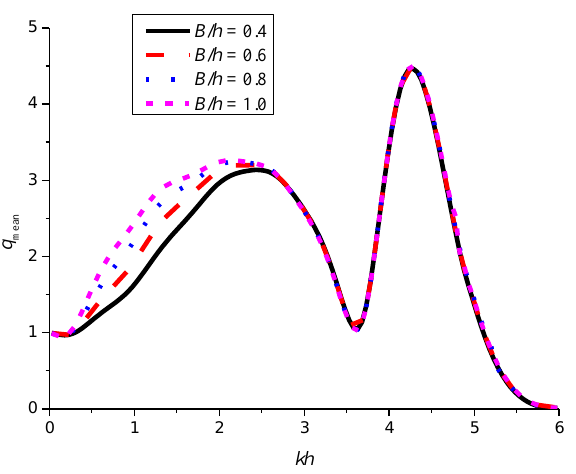
Figure 13. Variations of q mean vs. kh for the WEC array with different breadths B of the rear pontoon. Finally, the effect of length of the pontoon is investigated by the calculations with T / h = 0.25, B / h = 0.6 and four pontoon lengths of D / h = 12, 16, 20, and 24. From the corresponding results in Figure 14, it can be seen that the length of the pontoon has little effect on the variations of q mean .